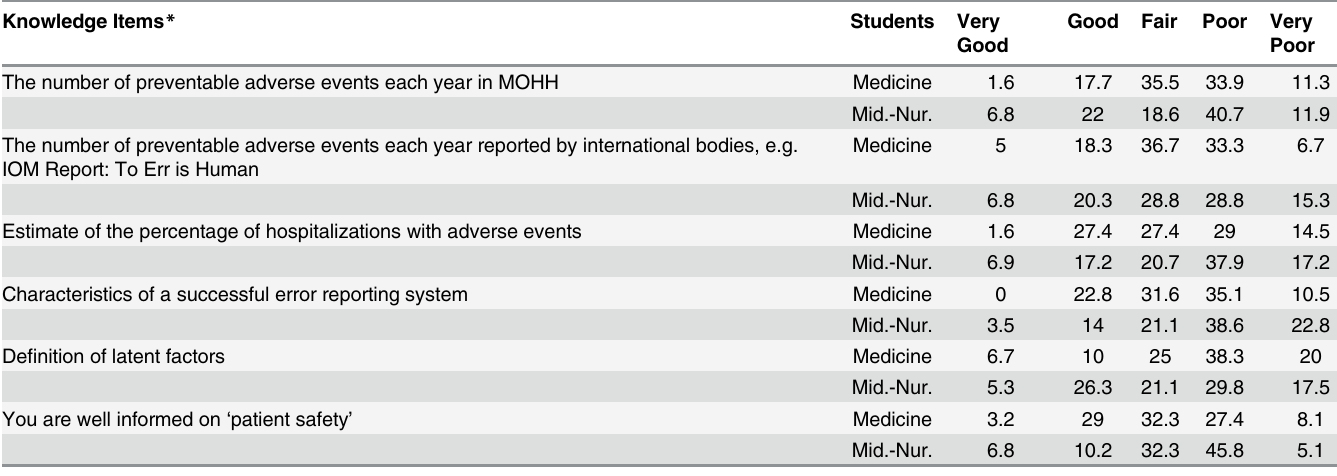
Table 2. Student's Knowledge on Patient Safety (n = 121).